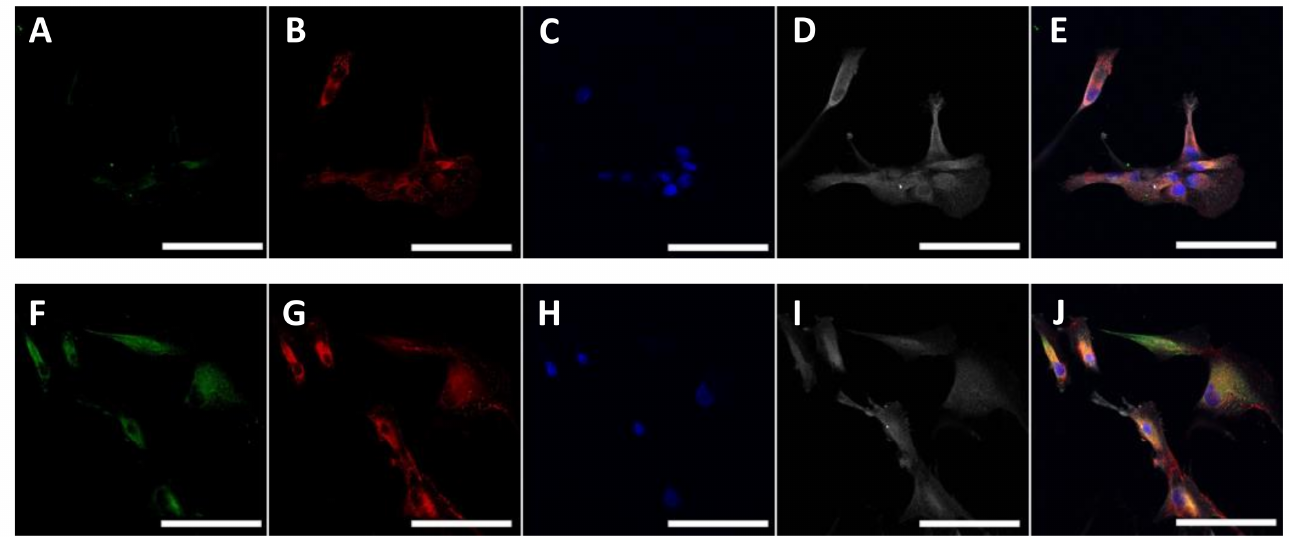
Figure A1. Expression of proteins in cardiac fibroblasts isolated from the human myocardium. Cardiac fibroblasts were isolated from disease human myocardium and cultured. Serial passages were conducted when cultures reached 70–90% confluency. Representative confocal images were obtained of human cardiac fibroblasts in passage 2 ( A – E ) and passage 5 ( F – J ). Alpha-smooth muscle actin (aSMA) (green) ( A , F ), fibronectin (red) ( B , G ), DAPI (blue) ( C , H ) and collagen (white) ( D , I ). Images were then combined ( E , J ). Scale bar = 100 µ